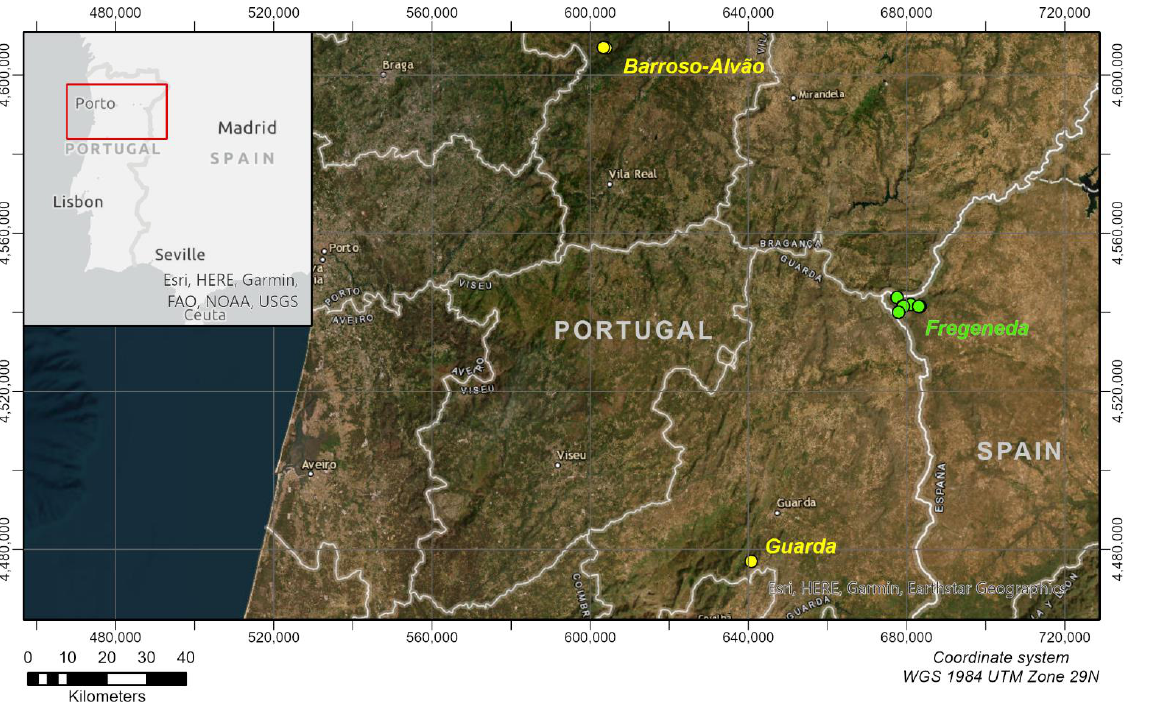
Figure 7. Locations of the database samples from the LCT-type pegmatite sites in Portugal (yellow) and Spain (green). The red frame in the inset map outlines the location map.